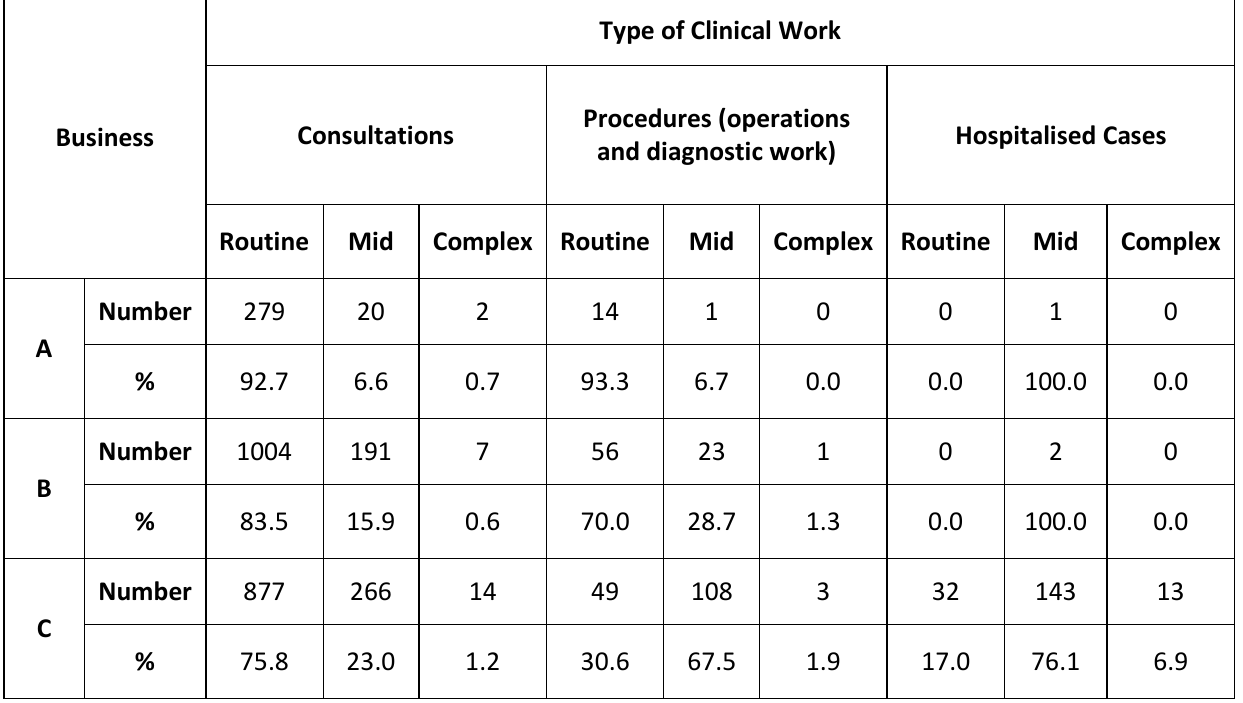
Figure 3. Segmentation of clinical work undertaken at three East Midlands small animal clinics The analysis in Figure 3 is representative of the UK sector and shows a marked difference between the three businesses in terms of both the types of work performed and the relative complexity within each